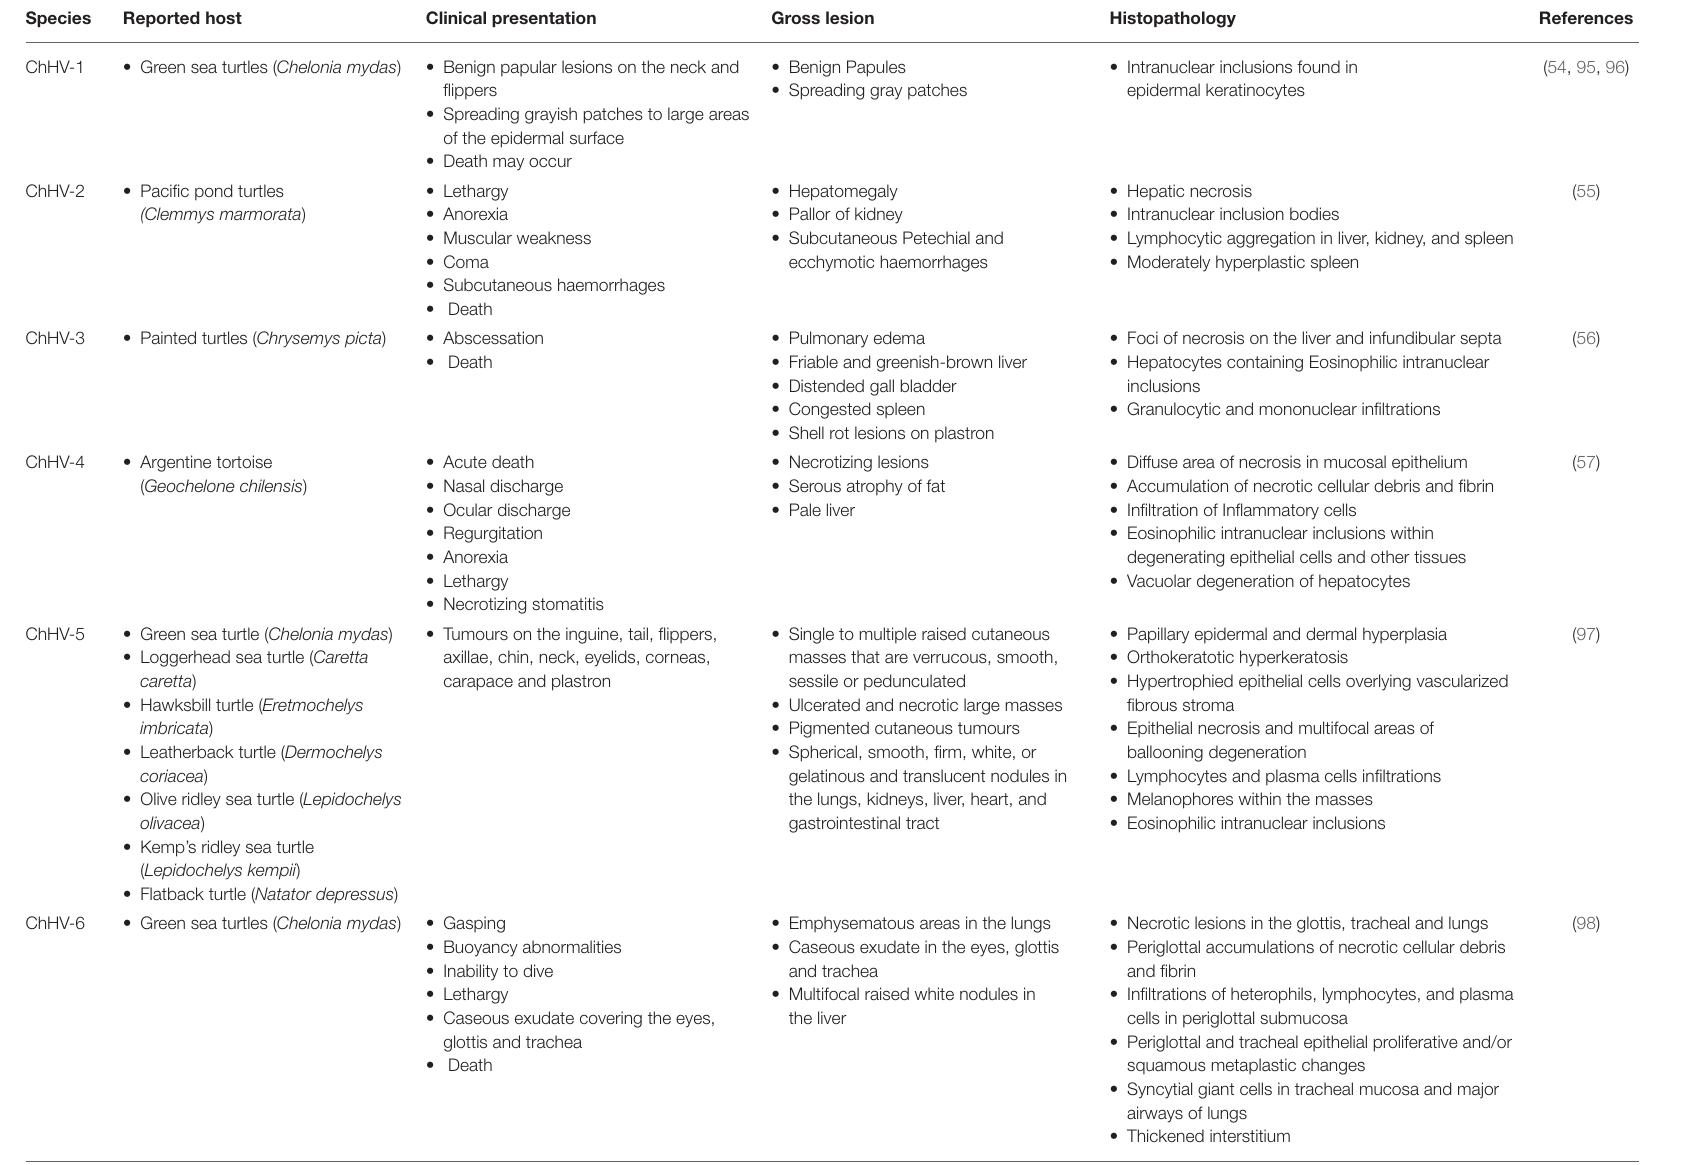
TABLE 2 | Clinical presentations, gross, and histological lesions of reptilian HV